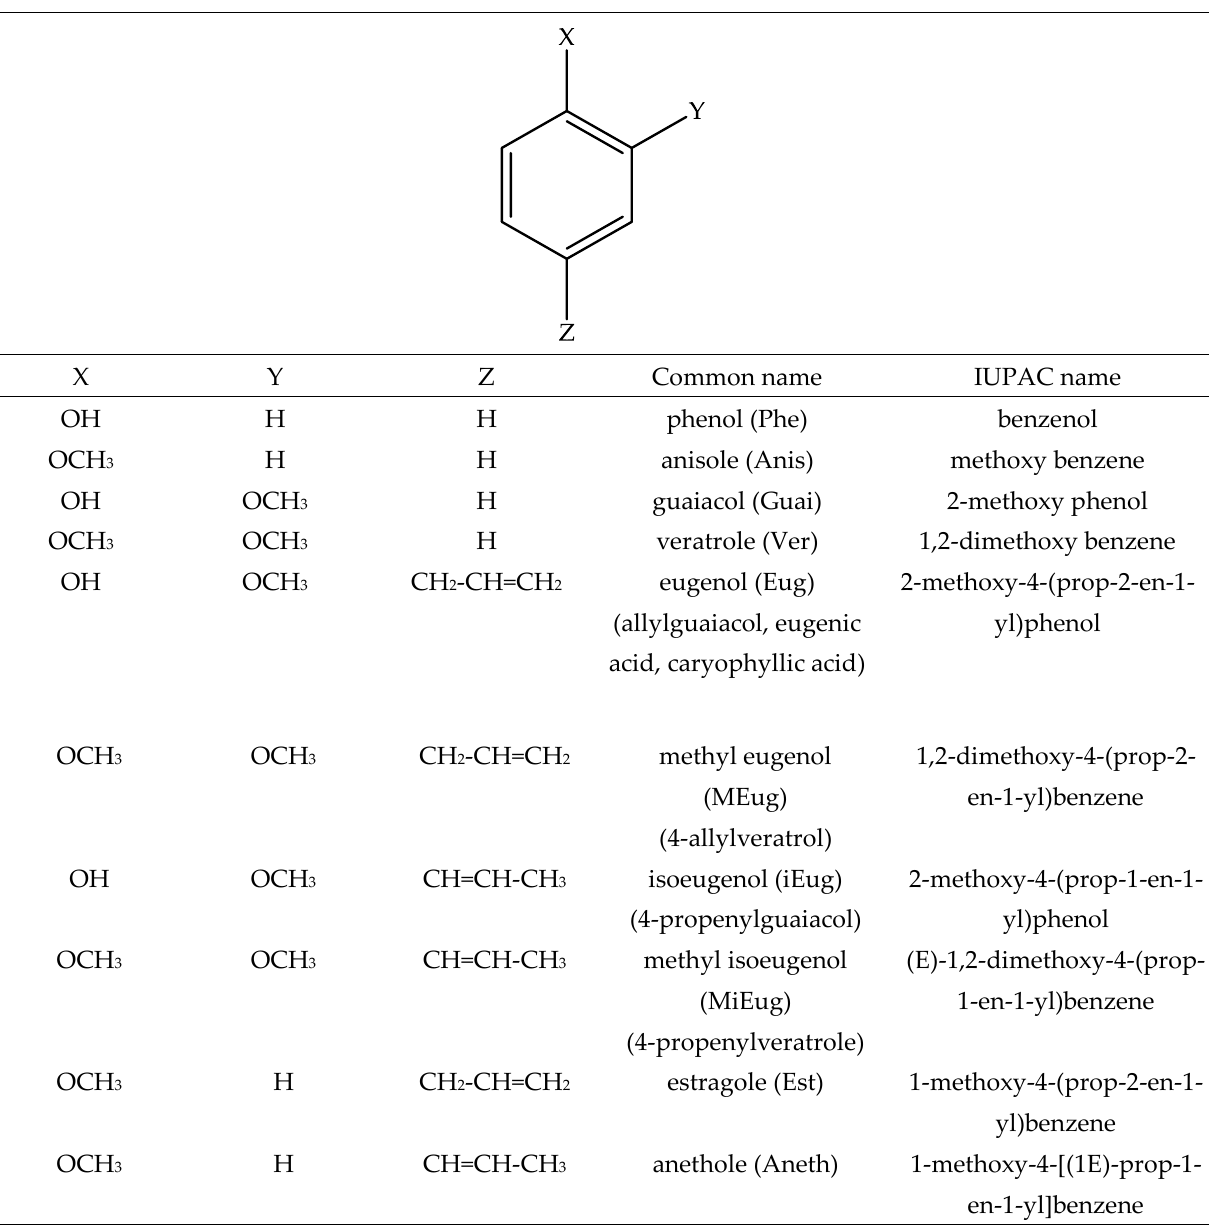
Figure 1. Structure of the test compounds.